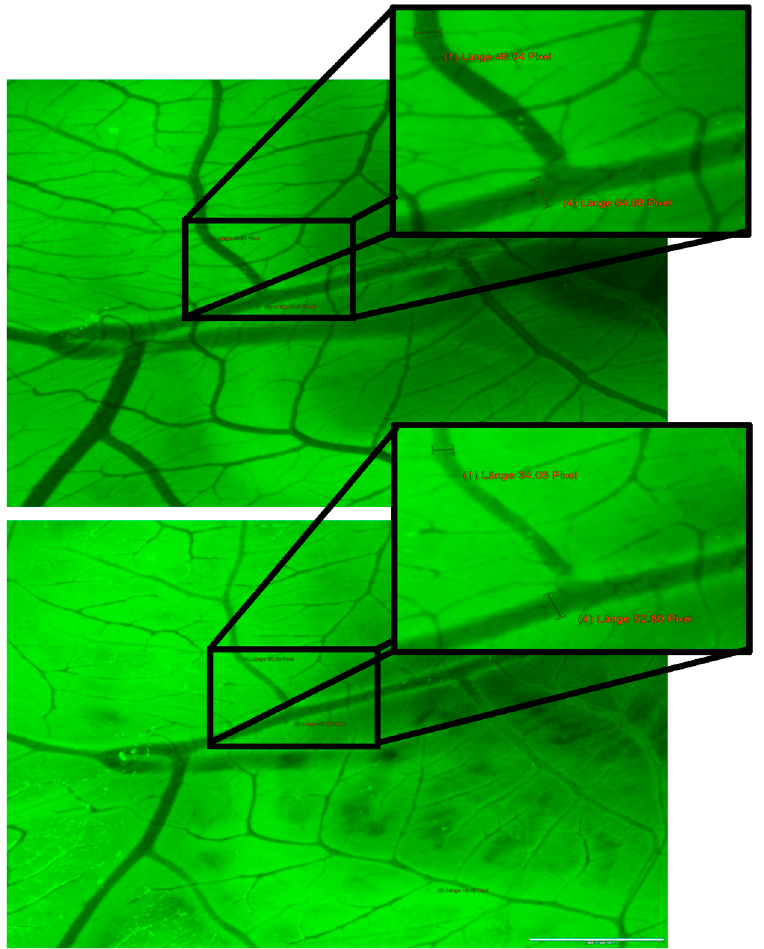
Figure 3. Example of vessel lumen assessment before ( A ) and after 10 min ( B ) of illumination. The white spots mark vessels with apparent changes in vessel